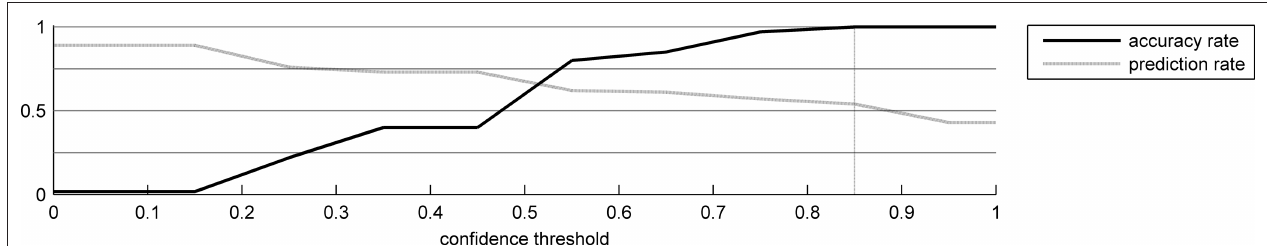
Figure 9 | results of the first algorithm having complete knowledge of the word